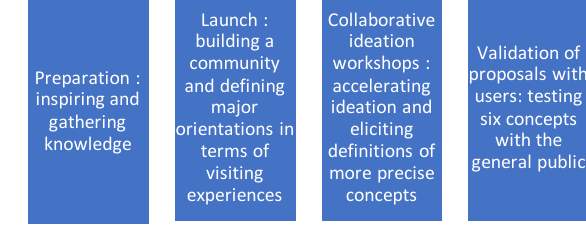
Fig. 1. The four steps of reinventing a